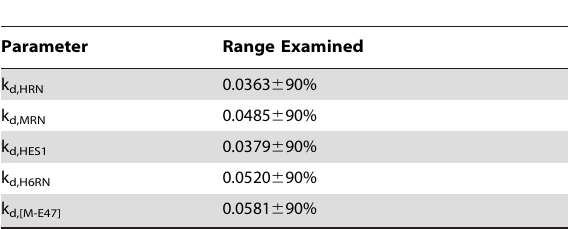
Table 3. GSA Results – Significant Parameters.